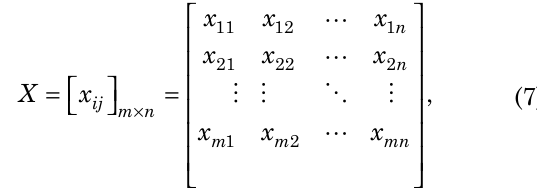
Table 2. The alternatives and the criteria used Criteria